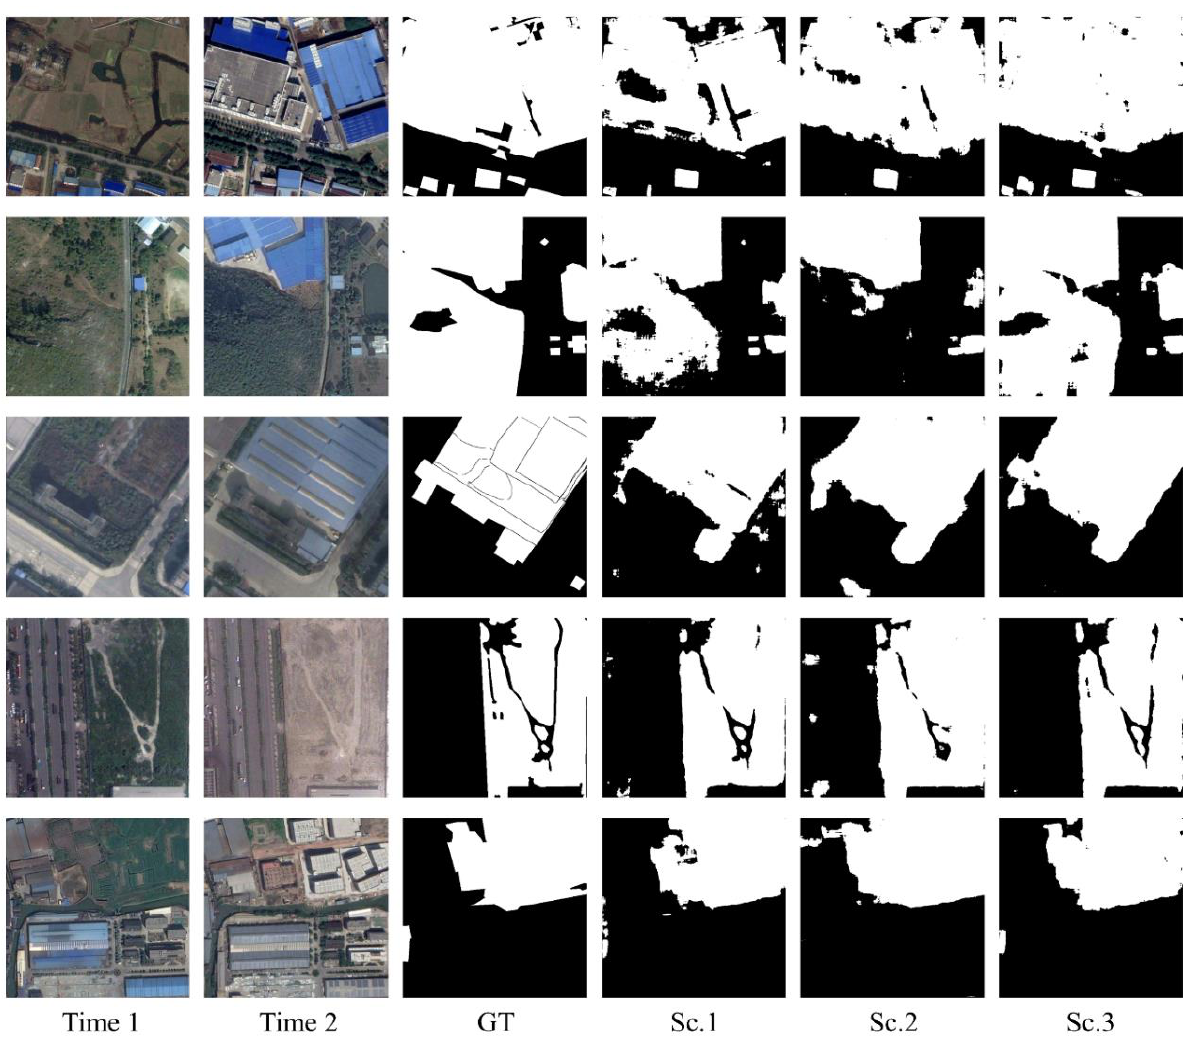
Figure 4. Visual results of the testing